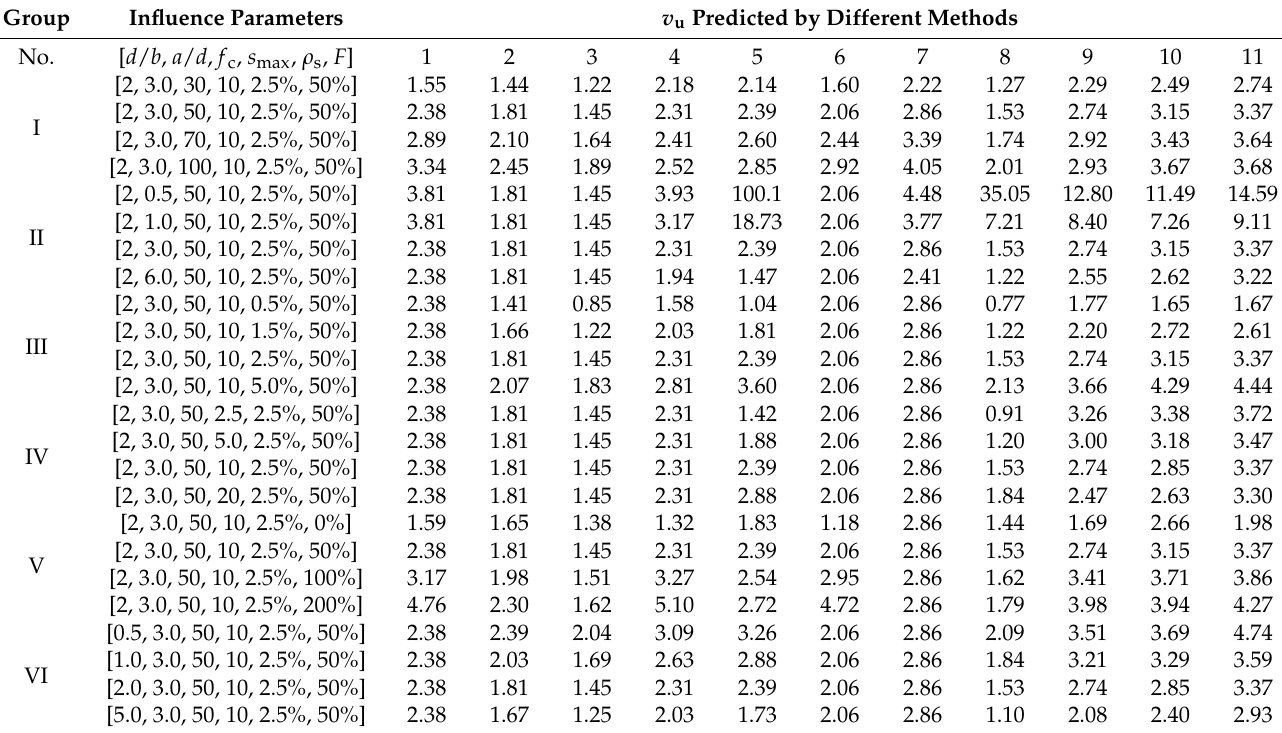
Table 5. Shear strengths of SFRC beams without stirrups predicted by different models. v u Predicted by Different